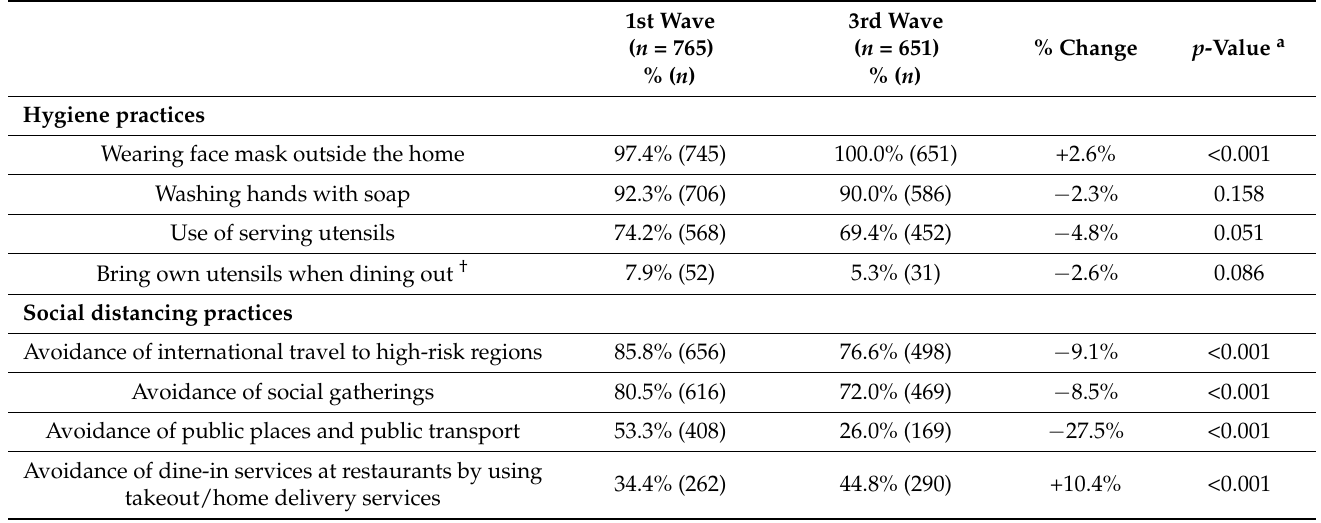
Table 2. Preventive behaviors against COVID-19